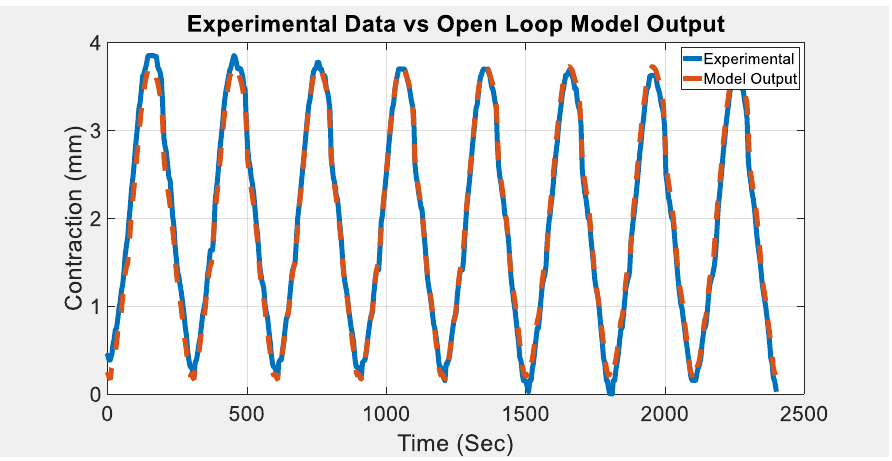
Figure 12. Time vs. contraction for the experimental data against the ANFIS model output.